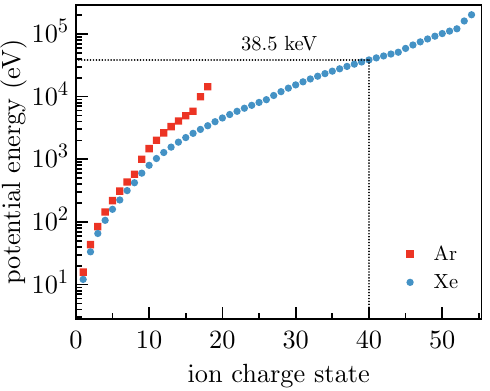
Figure 1. (Color online) Potential energy for Ar and Xe ions as a function of the charge state, e.g., Xe 40 + has a potential energy of 38.5